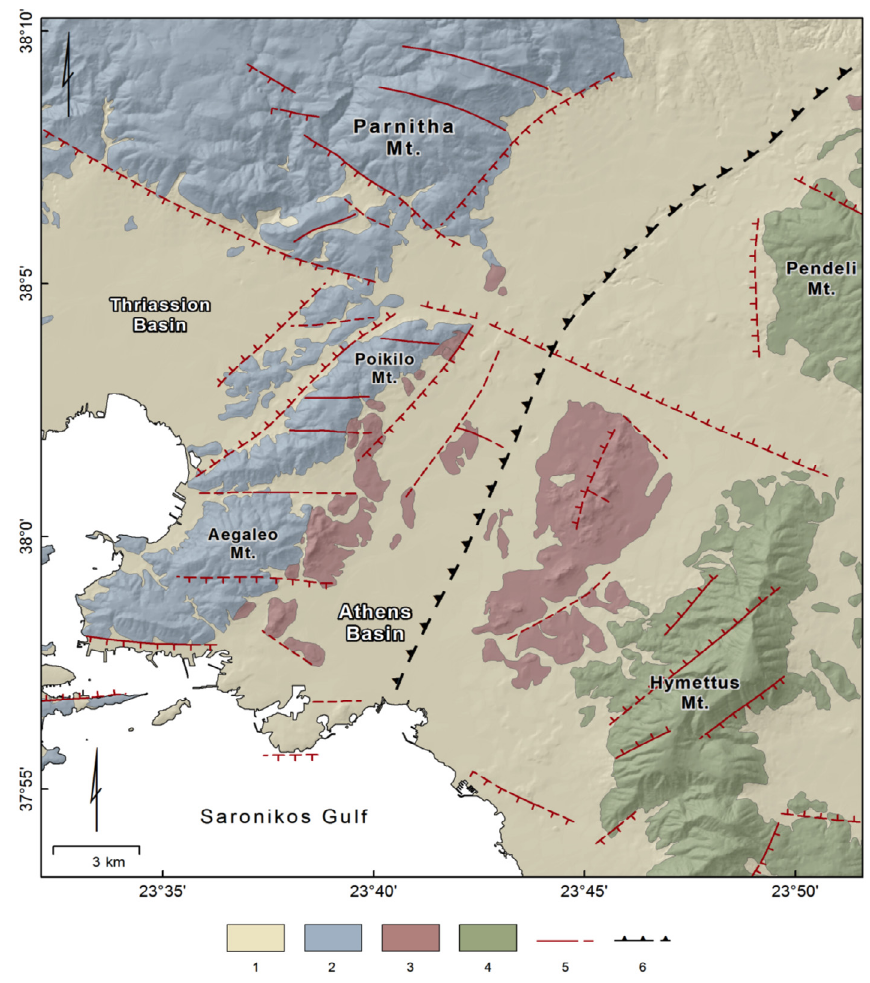
Figure 2. Geological map of the study area, (1) post-Alpine sediments, (2) non- metamorphic rocks (eastern Greece geotectonic unit), (3) allochthonous system (Athens schists), (4) metamorphic rocks (Attica geotectonic unit), (5) fault zone and (6) major tectonic